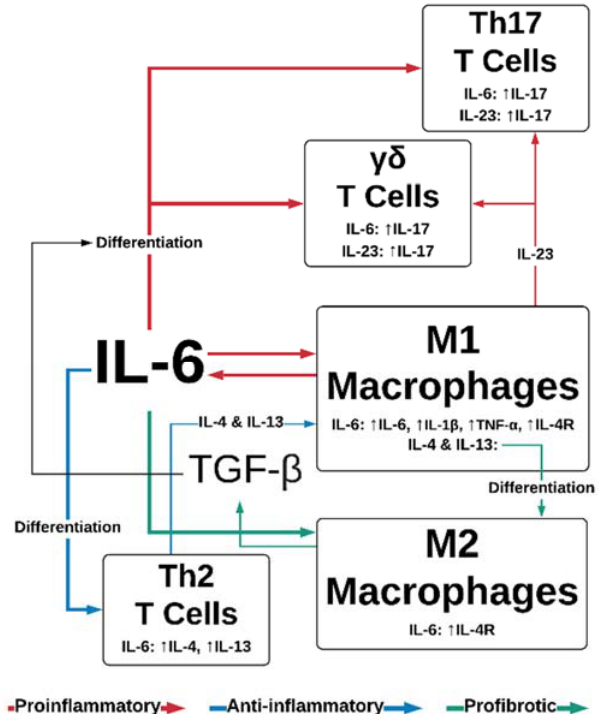
Figure 2. IL ‐ 6 and TGF ‐β effects on leukocyte function. IL ‐ 6 promotes the proinflammatory functions of Th17, γδ T ‐ cells, and M1 macrophages, while simultaneously promoting anti ‐ inflammatory Th2 differentiation and cytokine secretion. IL ‐ 6 also stimulates profibrotic responses in M2 macrophages, in conjunction with M1 / M2 polarization sustained by Th2 cytokines IL-4 and IL-23. TGF- β contributes in conjunction with M1/M2 polarization sustained by Th2 cytokines IL ‐ 4 and IL ‐ 23. TGF ‐β contributes to IL-6-dependent di ff erentiation of Th17 and γδ T-cells. IL—interleukin; TGF- β —tissue growth factor to IL ‐ 6 ‐ dependent differentiation of Th17 and γδ T ‐ cells. IL—interleukin; TGF ‐β —tissue growth β ; Th—T-helper; TNF- α —tumor necrosis factor α ; VEGF—vascular endothelial growth factor β ; Th—T ‐ helper; TNF ‐α —tumor necrosis factor α ; VEGF—vascular endothelial growth factor.